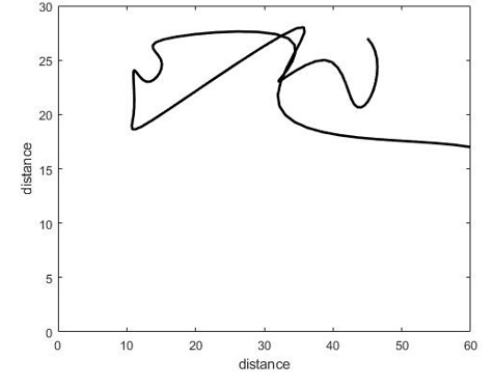
Figure 13. Single Partial abnormal path extracted using the prototype.